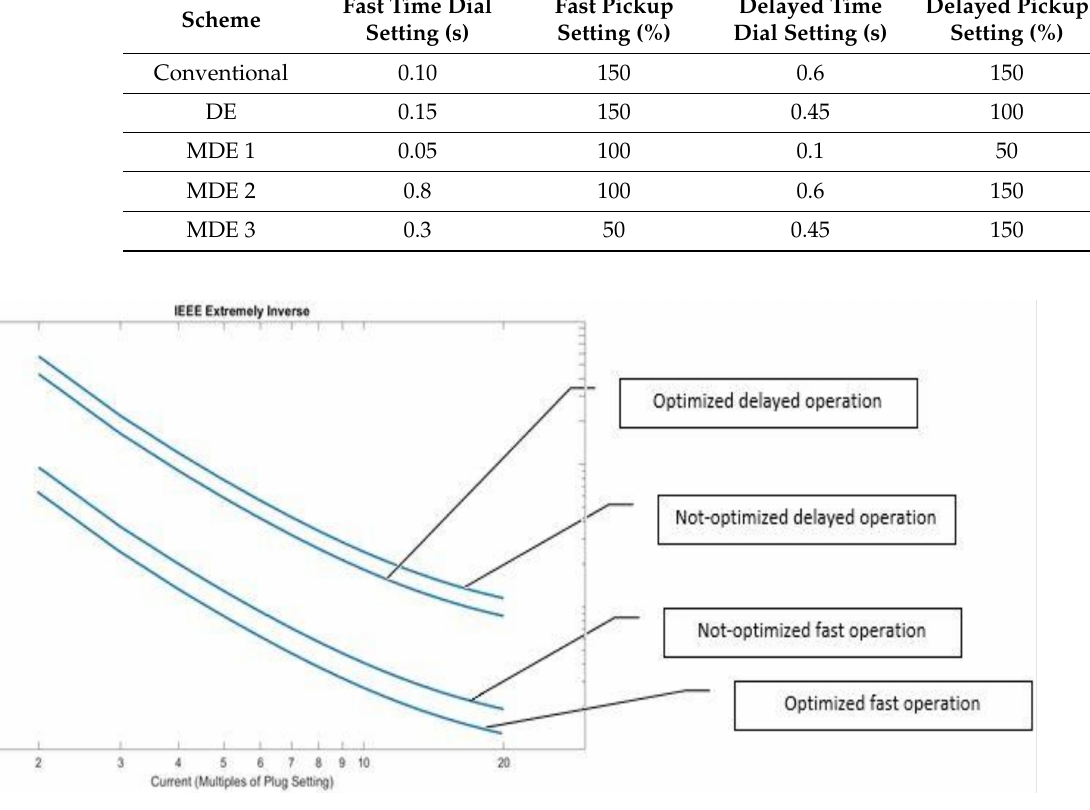
Figure 3. Comparison of the fast and delayed curves for the recloser using conventional settings and differential evolution algorithm